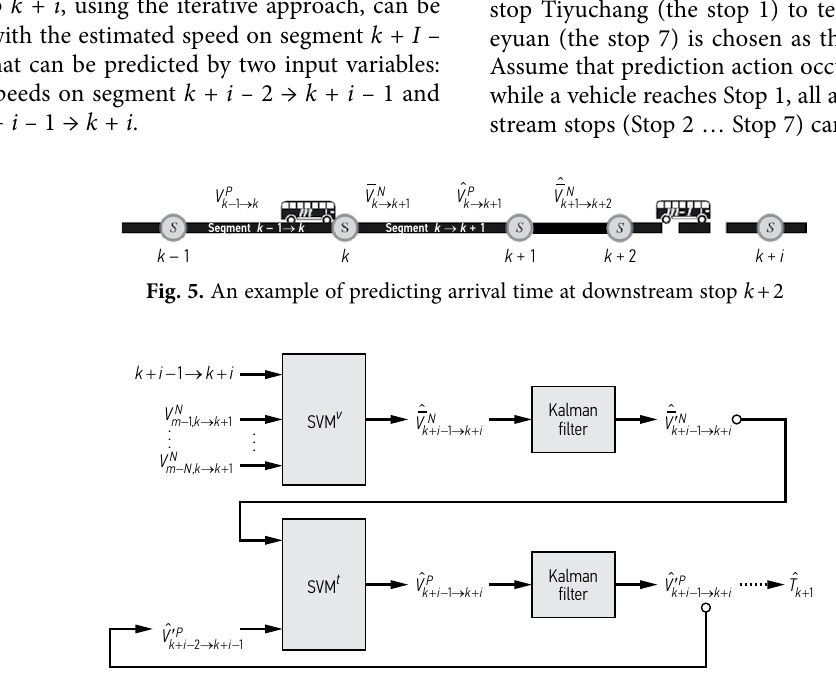
Fig. 6. The structure of the improved iterative prediction